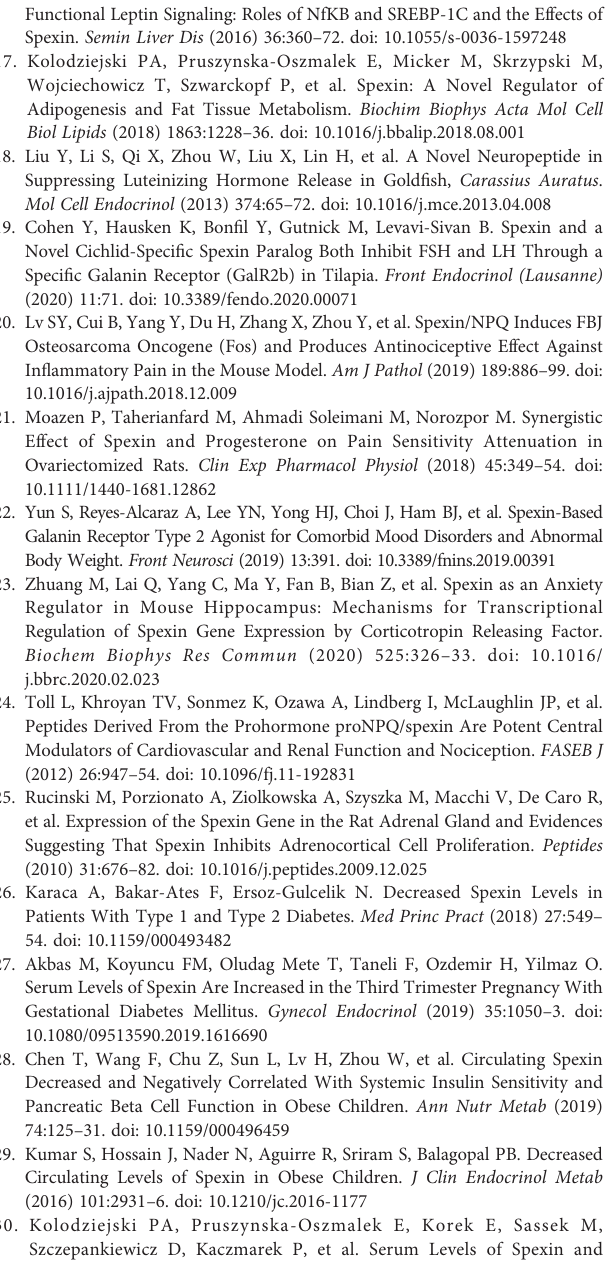
not in the generously allowed region/disallowed region, indicating that the receptor modeling are of good quality. Supplementary Figure 2 | Validation of antiserum speci fi city for detection of SPX. The speci fi city of the antiserum for mouse SPX was tested in an ELISA system using biotinylated mouse SPX as the tracer for displacement studies with (A) amidated and non-amidated forms of mouse SPX (m.SPX) and fi sh SPX (f.SPX), (B) related peptides evolved from the same gene lineage, including kisspeptin, galanin 15 and galanin 29, (C, D) unrelated peptide with similar size, including PACAP, VIP, secretin, NPY, a MSH and orexin A. In these studies, except for m.SPX and f.SPX (with ED 50 of 45.3 pg/ml and 32.9 ng/ml, respectively), the other peptides were not effective in displacing the binding of the SPX